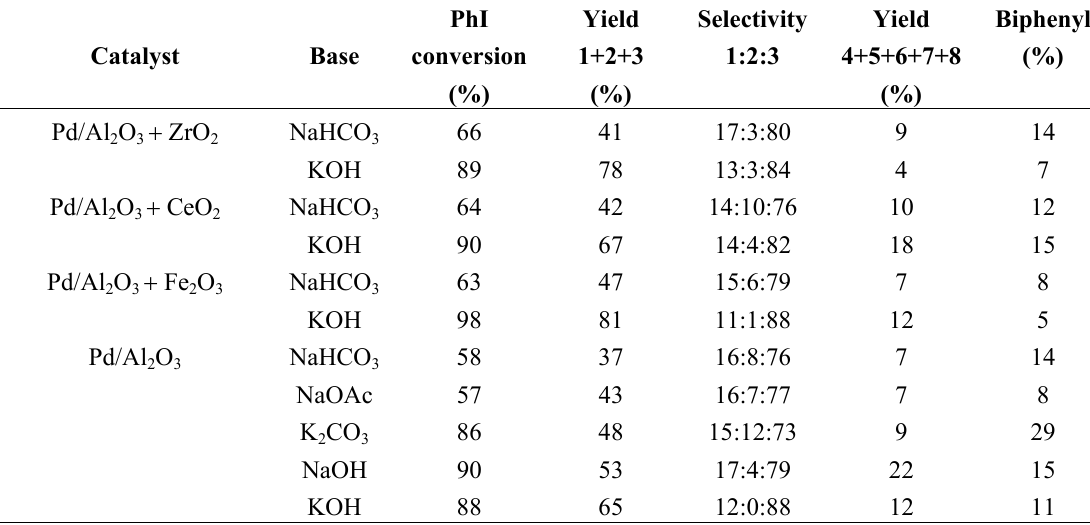
Table 3. Results of the Heck coupling of iodobenzene with cyclohexene catalyzed by Pd supported on alumina-based oxides in DMF. Catalyst Pd/Al O + ZrO 2 3